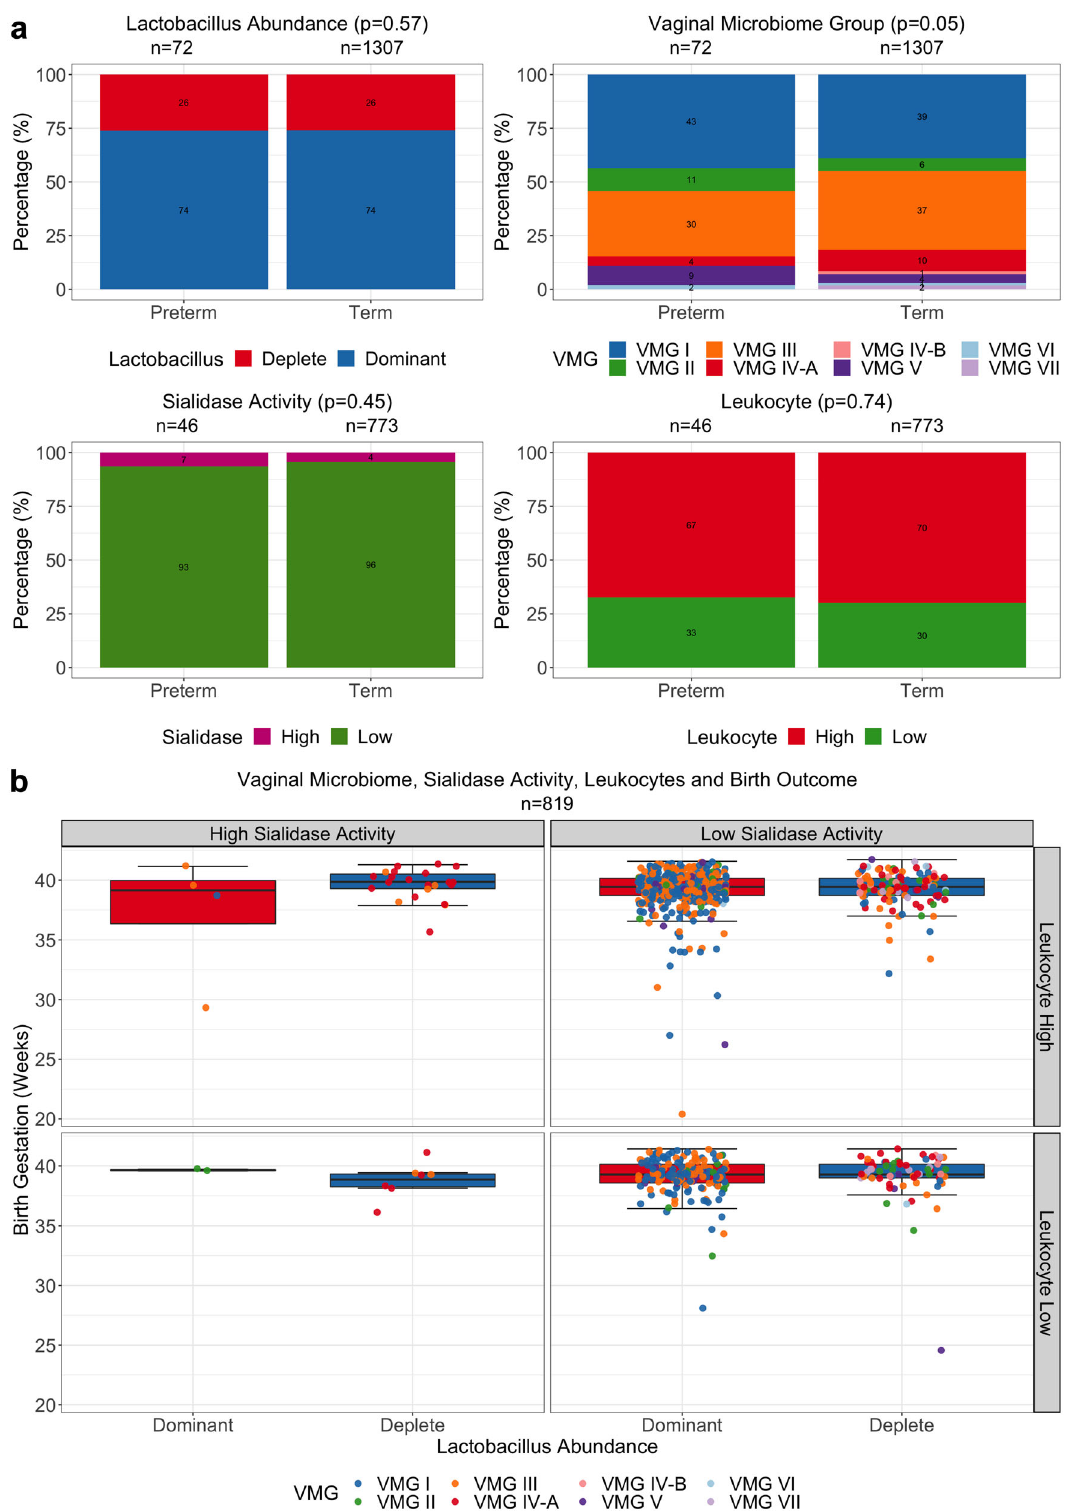
Fig. 4 Association between the vaginal microbiome, sialidase activity and leukocyte presence with birth outcome. a Stacked bar plots showing proportion of Lactobacillus abundance (deplete, red; or dominant, blue), vaginal microbiome groups (VMG), sialidase activity (high, pink; or low, red) and leukocyte low (grades I-II, green) or high (grades III-IV, red) in preterm and term groups. Statistical signi fi cance based on Fisher ’ s Exact Test. b Boxplots showing birth gestation in weeks grouped by Lactobacillus abundance, sialidase activity, and leukocyte presence or absence with dot points colored by VMG. The bounds of the box represent the fi rst and third quartiles, center line represents the median, and whiskers show min-to-max values. No signi fi cant difference between boxplots with n ≥ 3 based on Kruskal-Wallis Test, p >